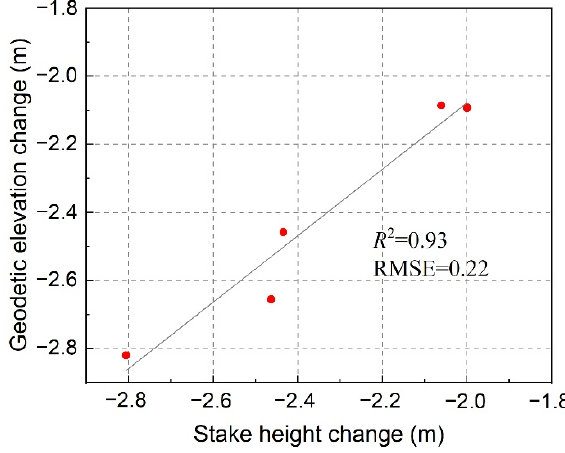
Figure 7. Comparison of the surface elevation change from two surveys and in situ measurements at each stake in the study area. The red dots represent the glaciological elevation change against geodetic elevation change at corresponding ablation stakes.